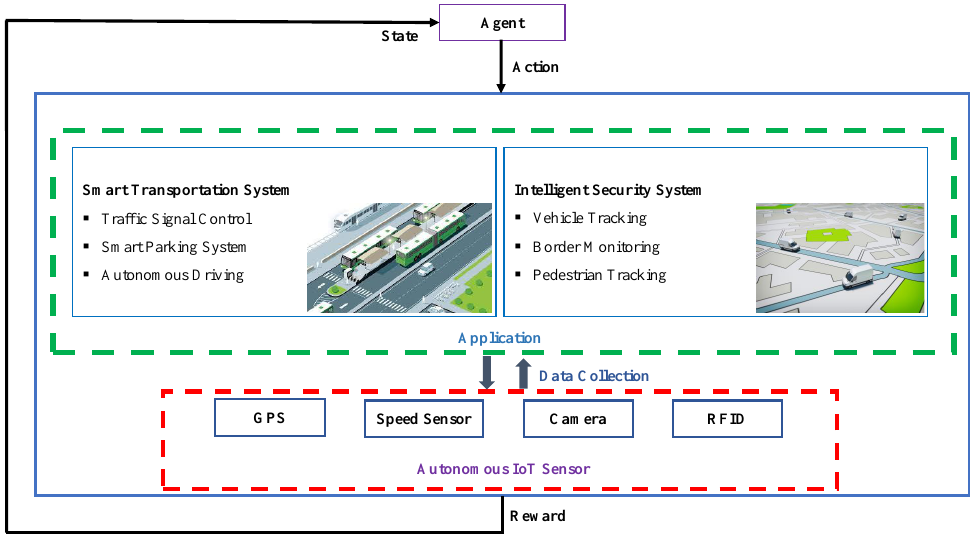
Figure 1. Autonomous IoT